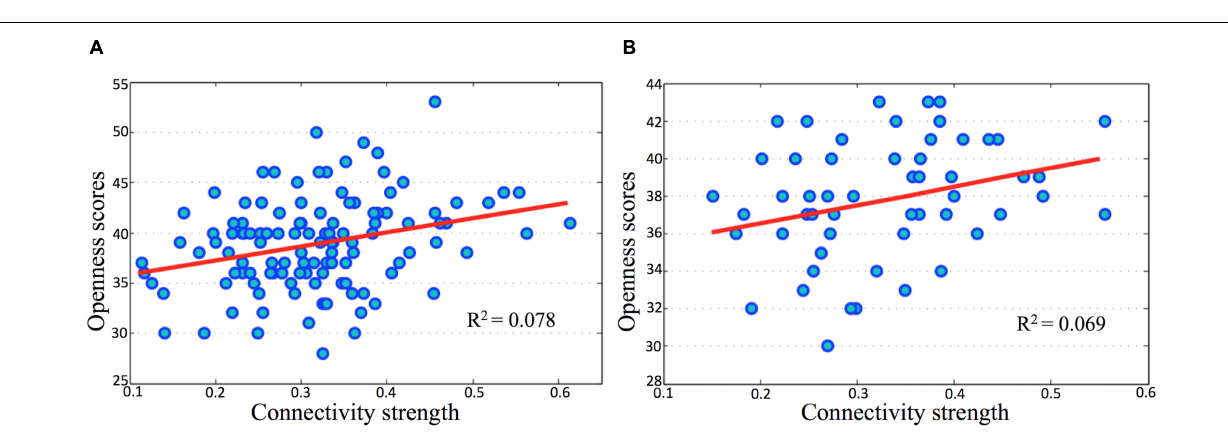
FIGURE 4 | Correlations between openness scores and connectivity strength in parietal memory network. The horizontal axes present connectivity strength (Fisher’s Z ) between the l-IPL and the r-IPL, and the vertical axes present the openness scores. (A) discovery sample, age and gender were controlled, r = 0.278, p < 0.01; (B) validation sample, age and gender were controlled, r = 0.277, p <